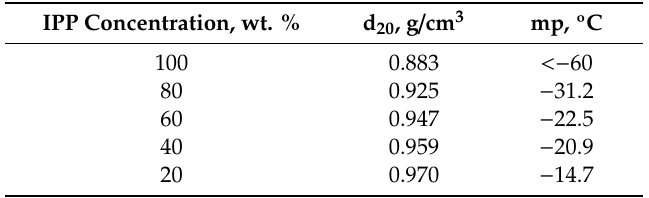
Table 11. The IPP aqueous solutions densities and the melting